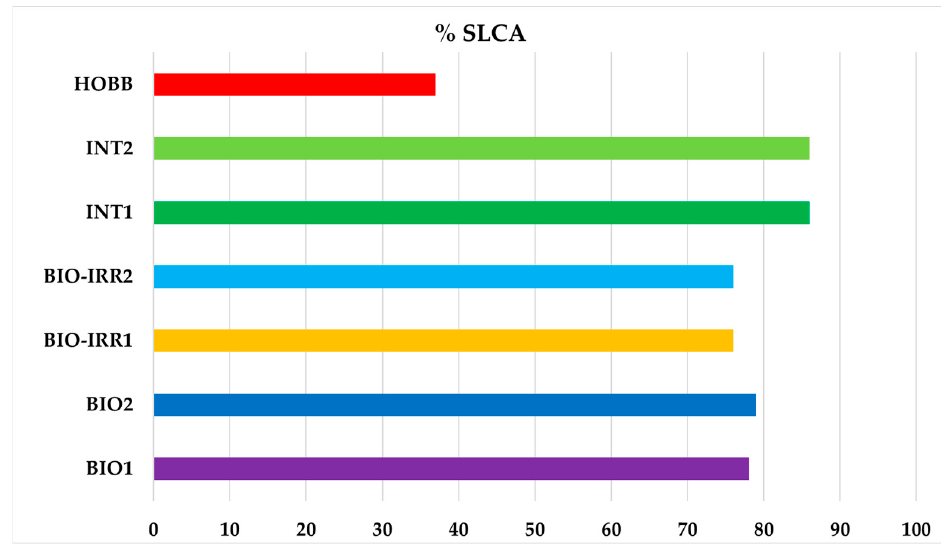
Figure 5. Distinction of the analyzed systems by percentage of Social Life Cycle Assessment (SLCA) sustainability.